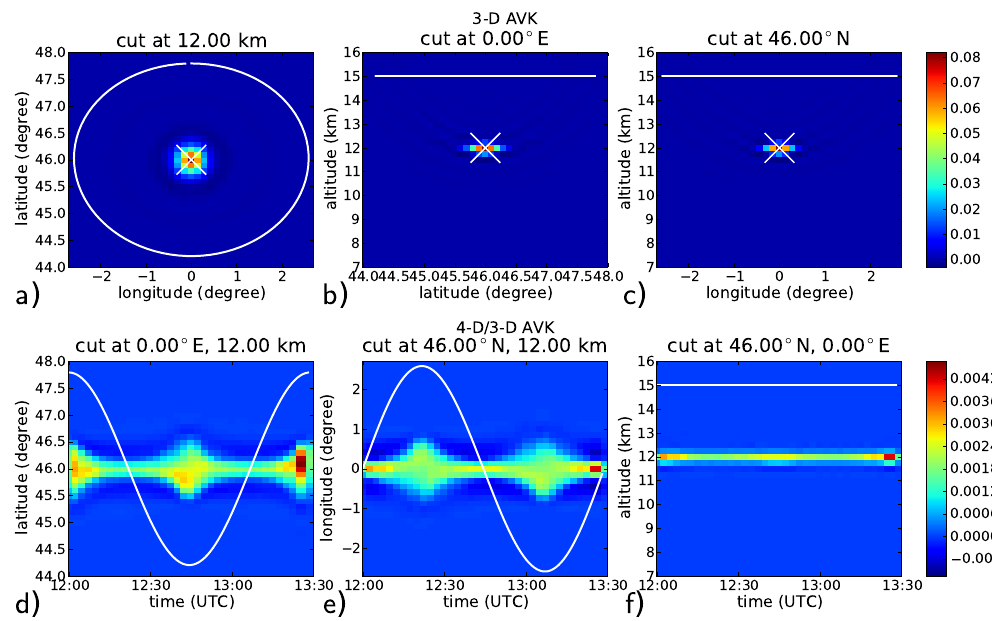
Fig. 12. A comparison between one row of the 3-D averaging kernel matrix and its 4-D/3-D equivalent for a central element. In the upper three panels, three cutting planes through a row of the 3-D averaging kernel matrix are depicted, all belonging to the element at 0 ◦ E, 46 ◦ N, and 12km altitude. The projection of the flight track of the instrument onto the cutting plane is drawn as a white line. The location of the data element is marked by a white cross. For the same data element, the three lower panels depict three cutting planes through the 4-D space described by the row of the 4-D/3-D averaging kernel matrix. cut at 46.00 ◦ N 39